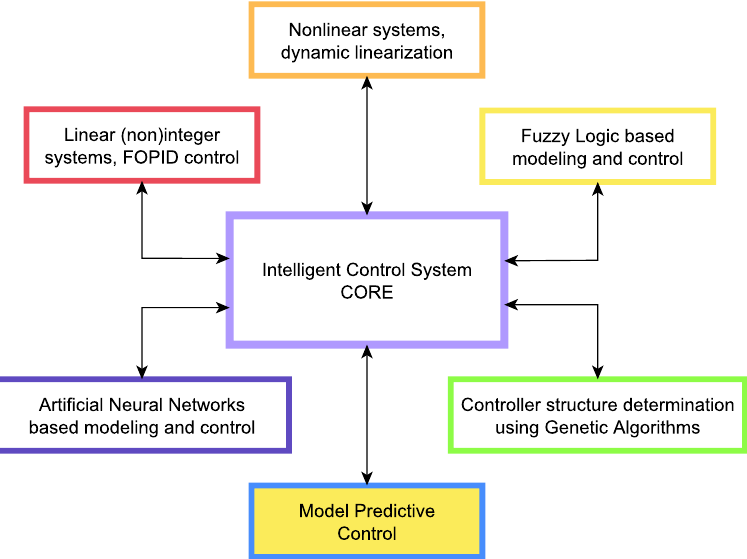
Figure 10. The overall framework developed in the scope of the present effort. The MPC module discussed in this paper is